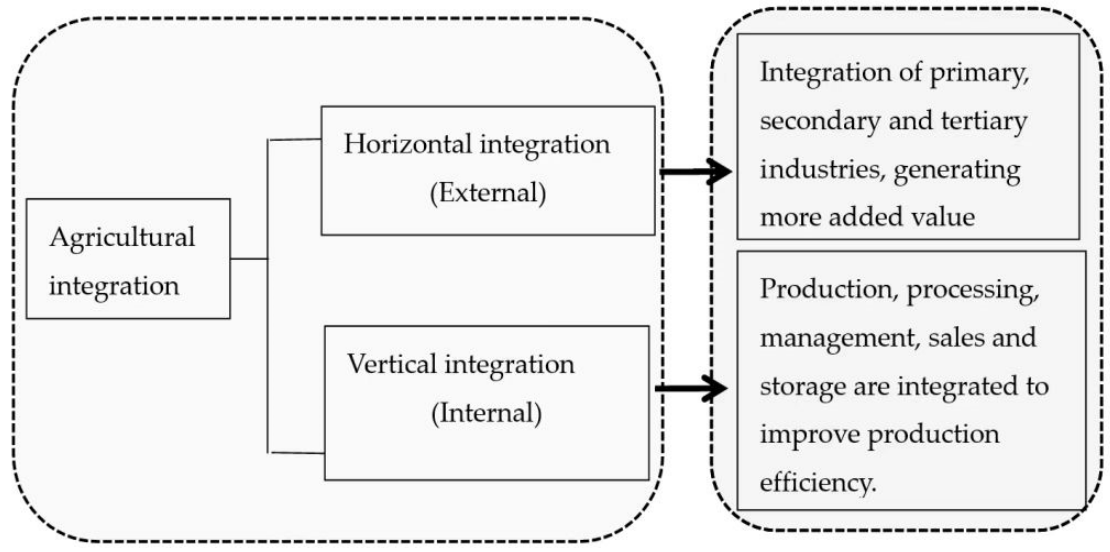
Figure 3. Categories of industrial agriculture integration. (Source: Drawn by the Authors).